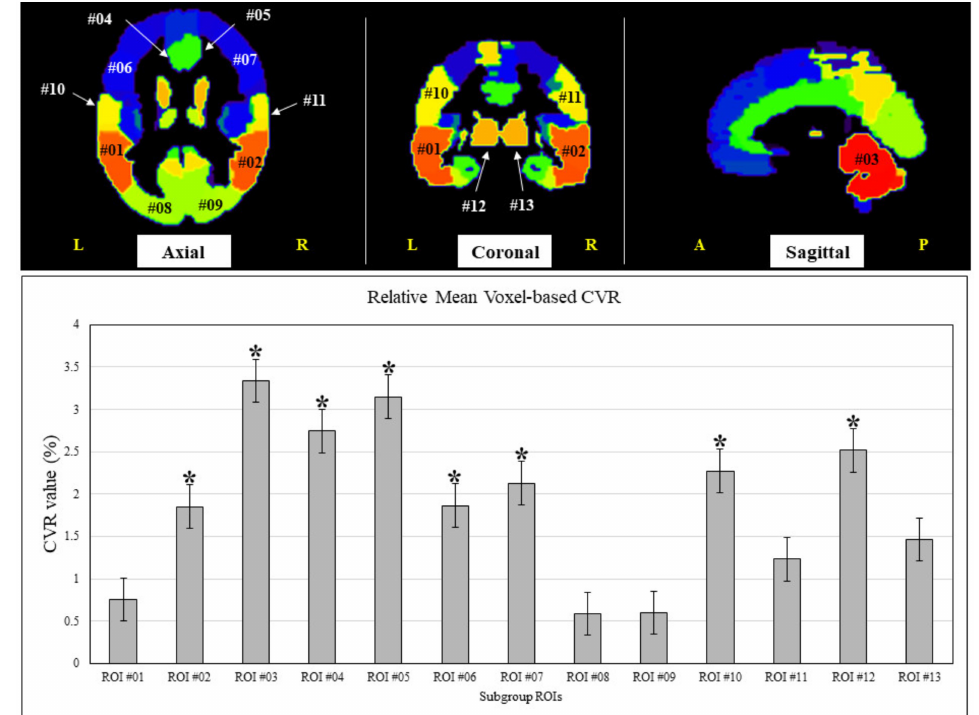
Figure 4. Graph of relative mean voxel-based CVR across 10 subjects in each of the 13 subgroup regions of interest (ROIs) according to a mean reference CVR value. ROI #01: left temporal cortex; ROI #02: right temporal cortex; ROI #03: vermis, medial; ROI #04: left insula/cingulate; ROI #05: right insula/cingulate; ROI #06: left frontal cortex; ROI #07: right frontal cortex; ROI #08: left occipital cortex; ROI #09: right occipital cortex; ROI #10: left parietal cortex; ROI #11: right parietal cortex; ROI #12: left central cortex; and ROI #13: right central cortex (see Table 2). Abbreviations: L, left; R, right; A, anterior; P, posterior; * indicates statistically significance ( p <